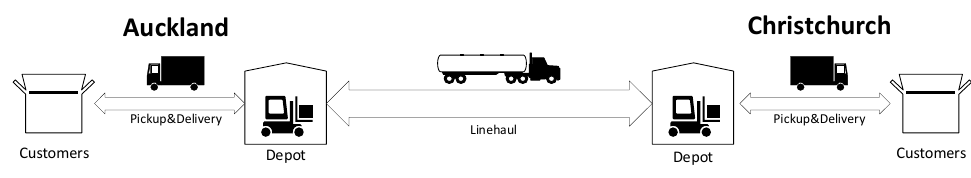
Figure 6. Illustration of freight transport.